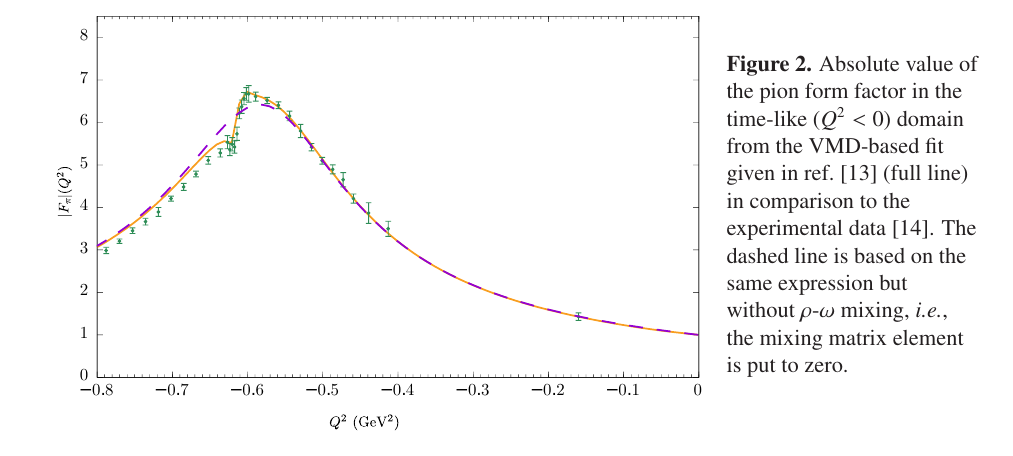
Figure 2. Absolute value of the pion form factor in the time-like ( Q 2 < 0) domain from the VMD-based fit given in ref. [13] (full line) in comparison to the experimental data [14]. The dashed line is based on the same expression but without ρ - ω mixing, i.e. , the mixing matrix element is put to zero. 0